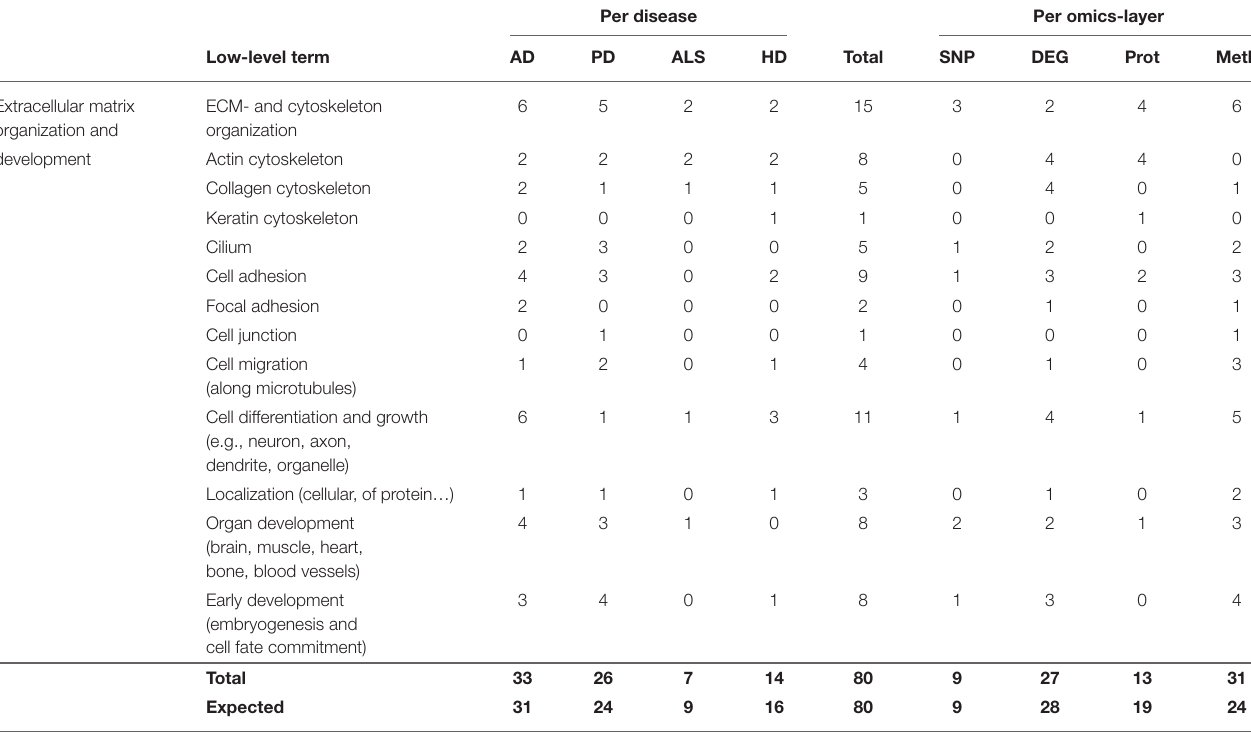
Per disease Per omics-layer